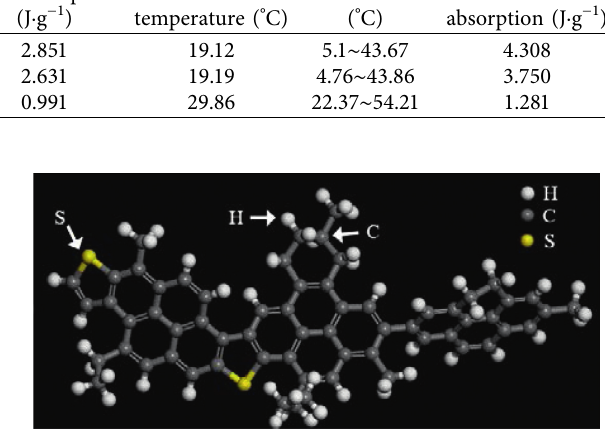
Figure 8: Asphaltene molecular structure.